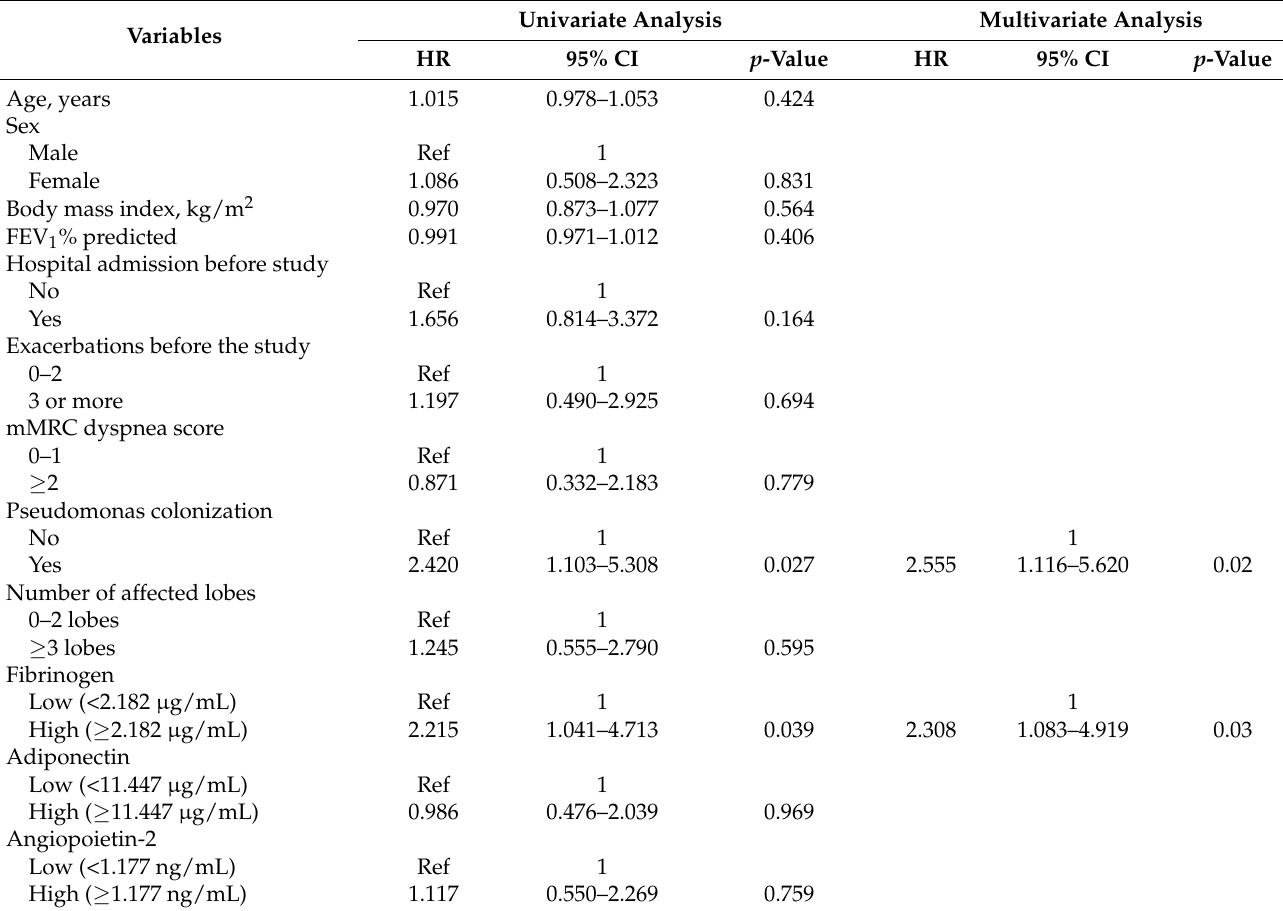
Table 3. Univariate and multivariate Cox proportional hazards model of exacerbation during the observation